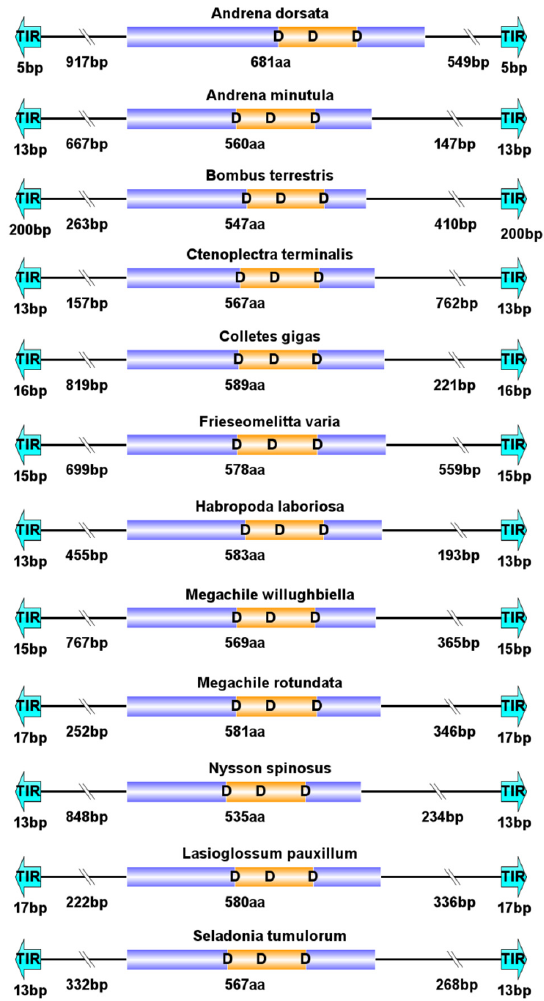
Figure 2. Structural organization of complete and representative piggyBac ( PB ) elements in Apoidea. (1) The bright blue part represents the terminal inverted repeats (TIRs) at both ends of the PB transposons; (2) The purple part represents the ORF; (3) The yellow part in the middle represents the catalytic domains; (4) The corresponding length of each section is marked below. Table 2. Structure organization of piggyBac (PB )